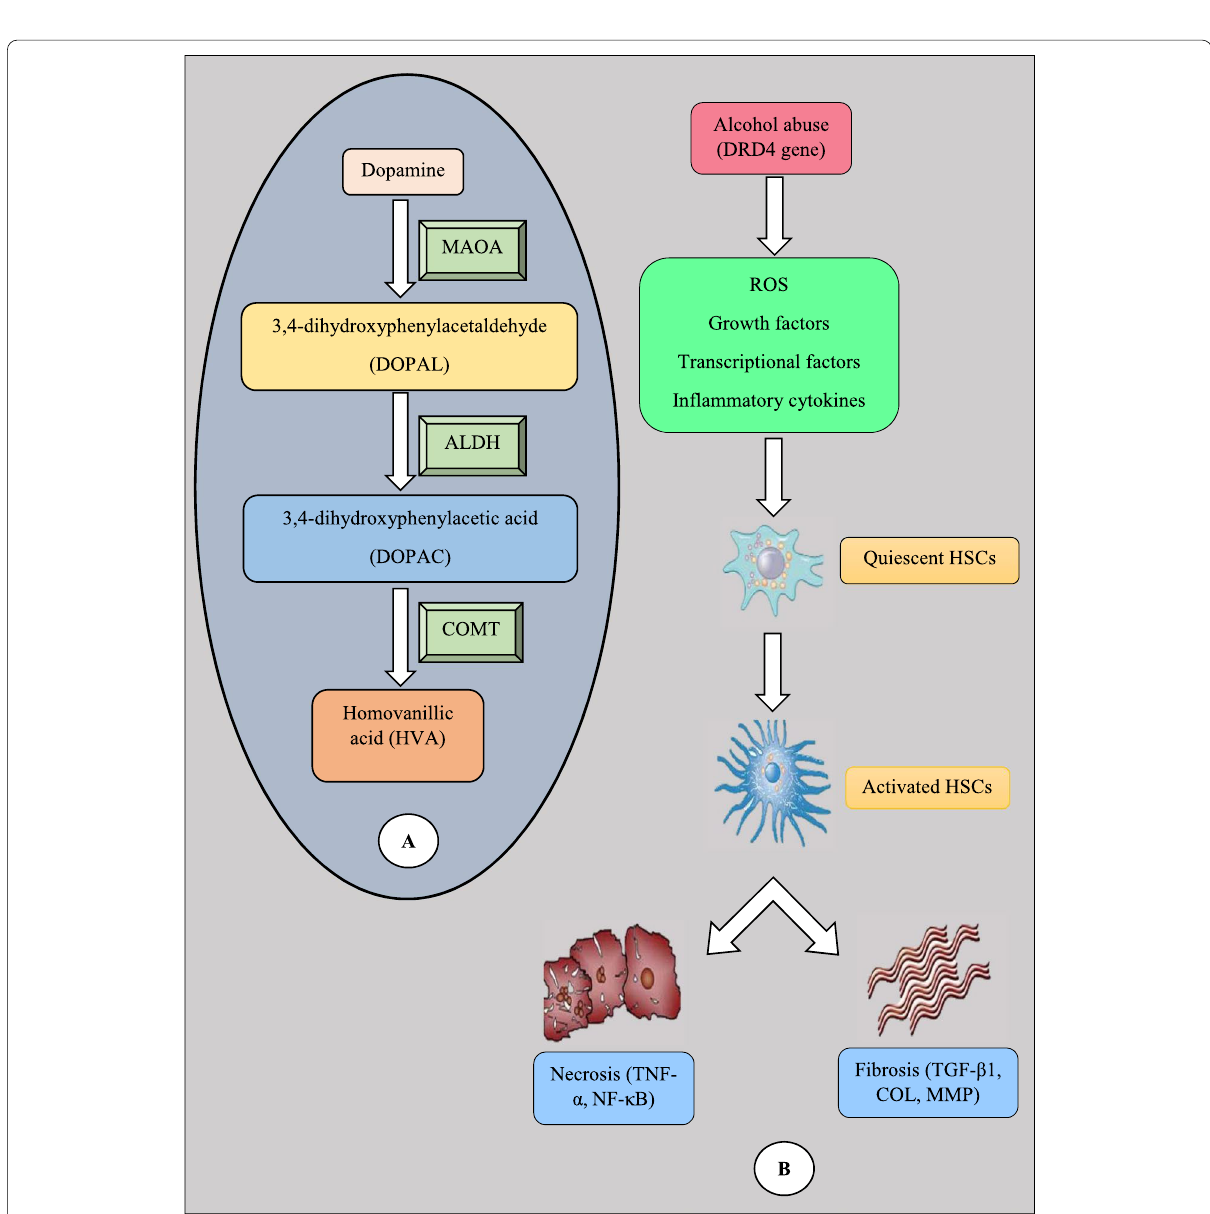
Fig. 8 A The metabolic pathway of dopamine. B Hepatic fibrogenesis by the DRD2 gene and different etiological factors induce several stimuli to HSCs